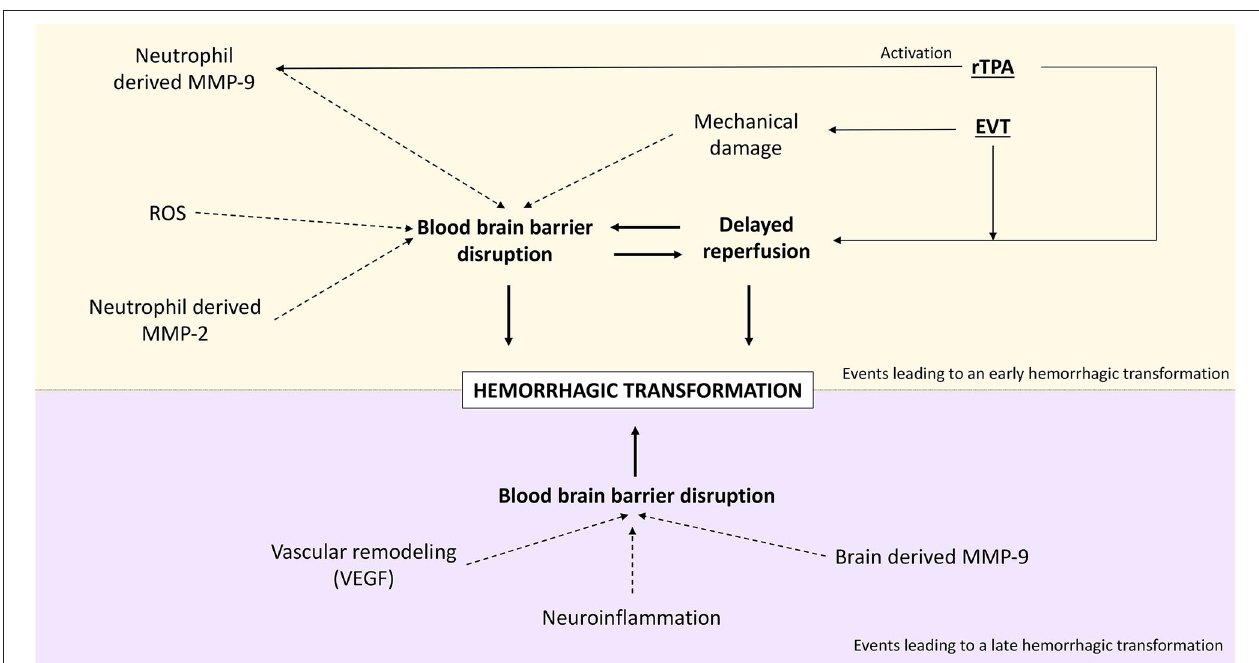
FIGURE 3 | Main events leading to hemorrhagic transformation after stroke.